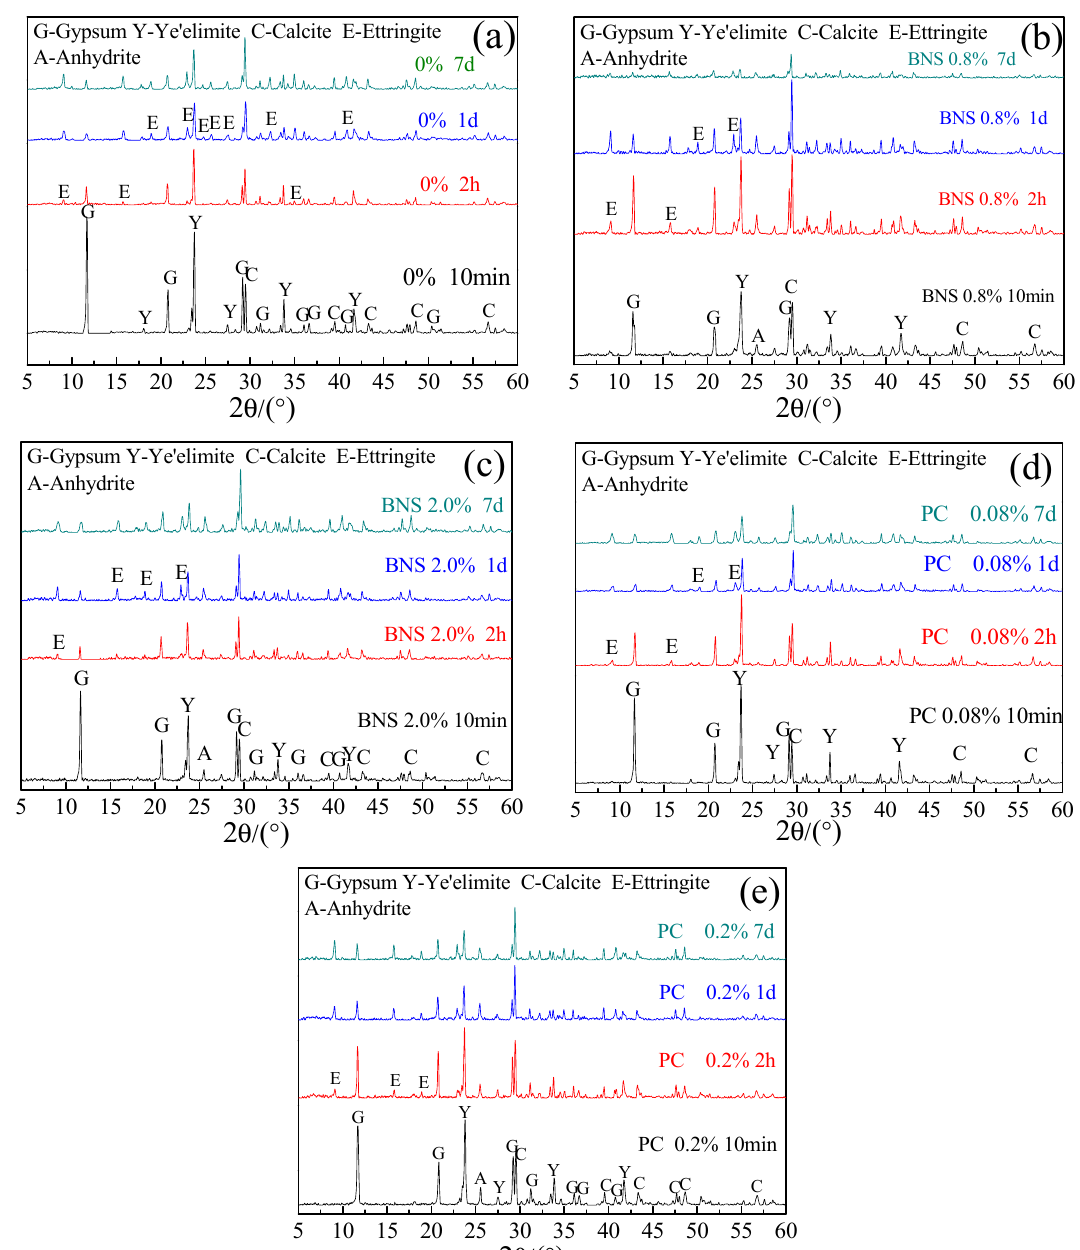
Figure 4. C 4 A 3 S pastes XRD patterns of ( a ) without superplasticizers, ( b ) BNS-0.8%, ( c ) BNS-2.0%, ( d ) PC-0.08%, ( e ) PC-0.20% with 10 min, 2 h, 1 d, 7 d.